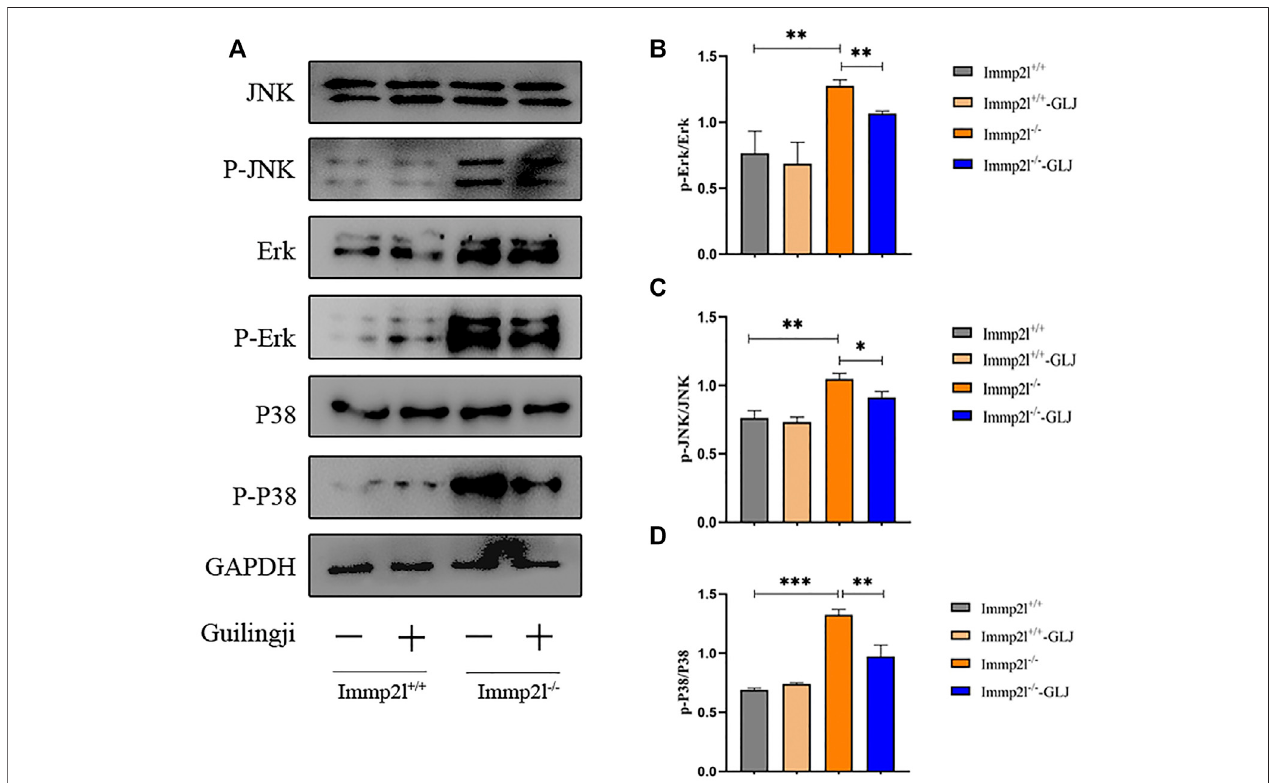
FIGURE 6 | The effects of Guilingji on the expression of proteins related to MAPK signaling pathways. (A) Relative expression of p-JNK, p-p38 and p-ERK was assayed through western blot. (B – D) Quantitation of relative protein levels of p-JNK, p-P38 and p-ERK respectively. The bars showed means ± SEM of three independent experiments. * p < 0.05, ** p < 0.01, *** p < 0.001. n (cid:1) 3.